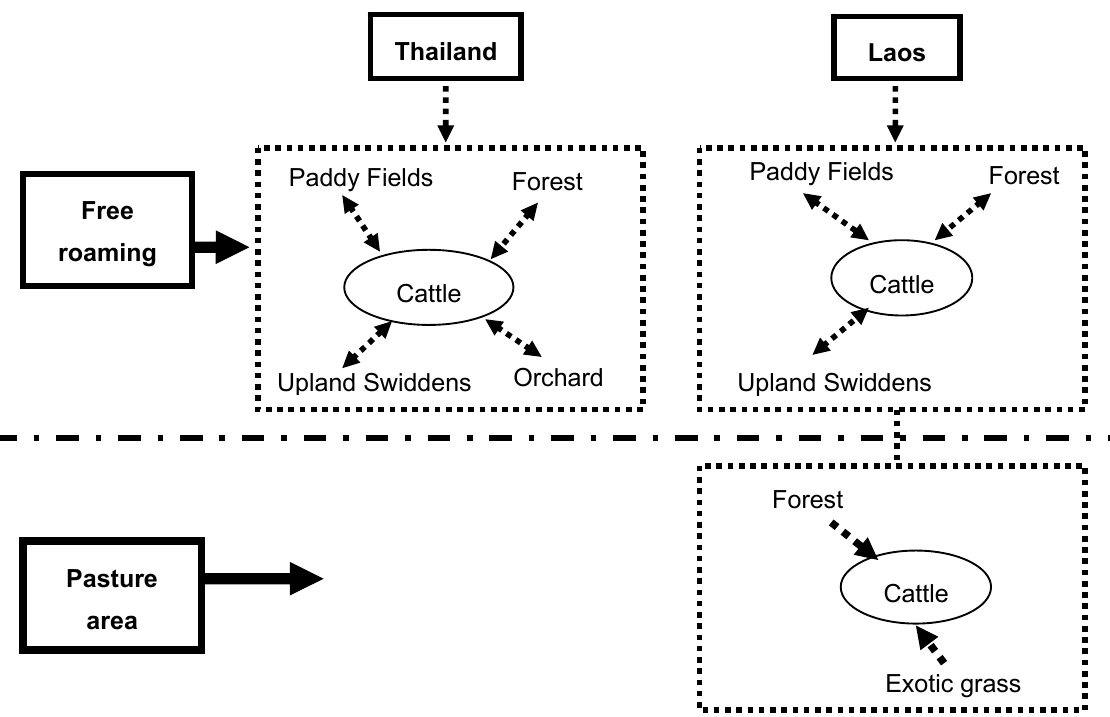
Figure 3. Different areas of occurrence of traditional agrosilvopastoral systems in Thailand and Laos. Source: Group